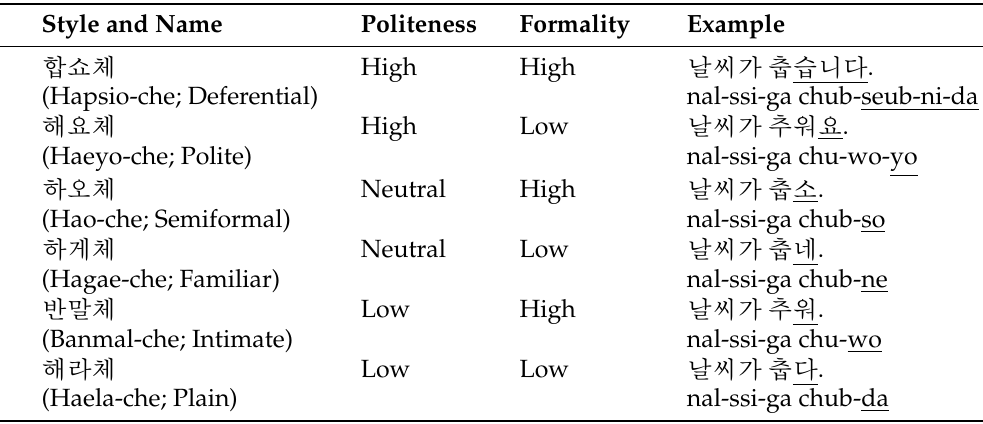
Table 1. Speech levels and sentence endings in Korean. Names are translated with respect to [8]. Each of the example sentences are a translation of: The weather is cold. Each underllined sentence ending corresponds to their addressee